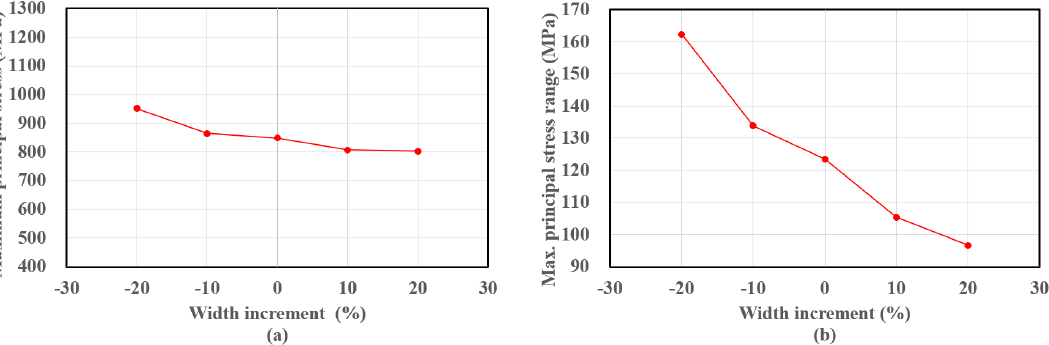
Figure 13. Stress variation with the spring width: ( a ) maximum principal stress; ( b ) maximum principal stress